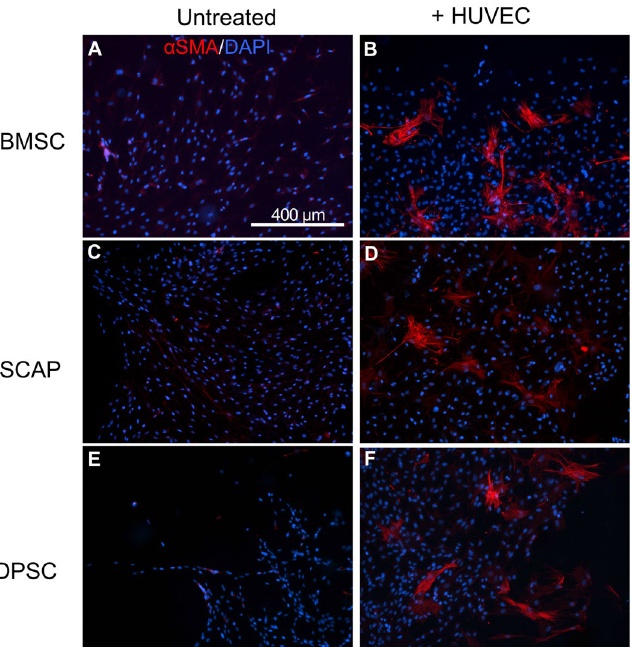
Figure 1. ( A , C , E ) Stem cells seeded onto GelMA hydrogels (2D) without HUVECs showed no expression of α SMA. ( B , D , F ) When co-cultured with HUVECs, stem cells from all three sources showed visible expression of the pericyte-related marker α-SMA, thus suggesting their consistent differentiation.